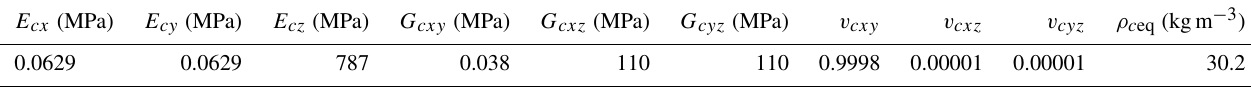
Table 8. Equivalent material parameters of the honeycomb core layer of ELM.